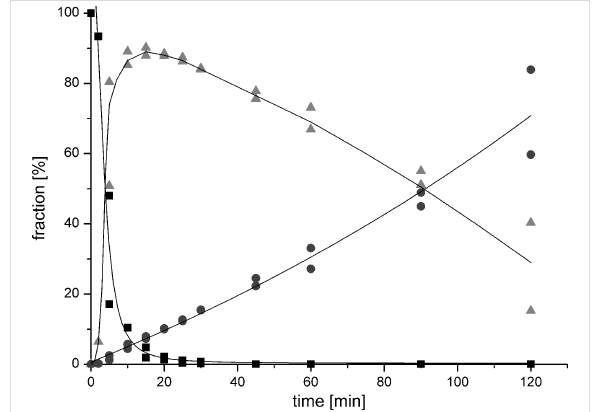
Figure 1: Conversion of 3b (squares) to the corresponding α , β - unsaturated aldehyde 7b (triangles) and side products (circles) at 95 °C and pH 9. Percentages of the products were calculated by inte- gration of HPLC signals at 254 nm in relation to the sum of all peak integrals at 254 nm. Shown are single values of two independent